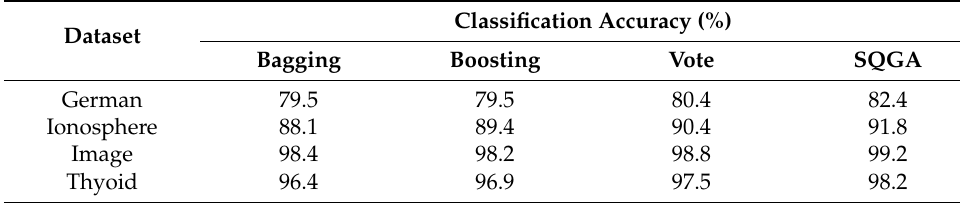
Table 3. Classification accuracy results of ensemble algorithm.